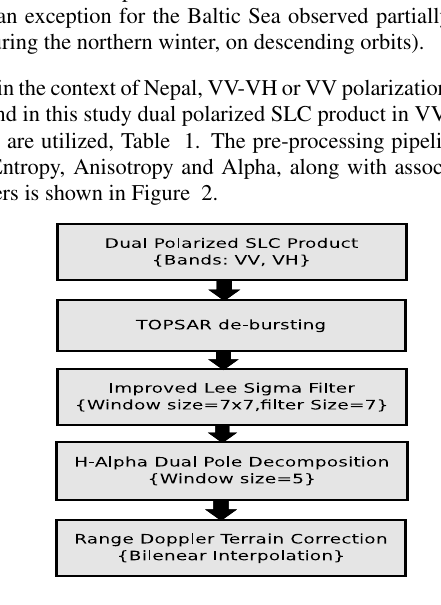
Figure 2: H-Alpha Decomposition Pipeline